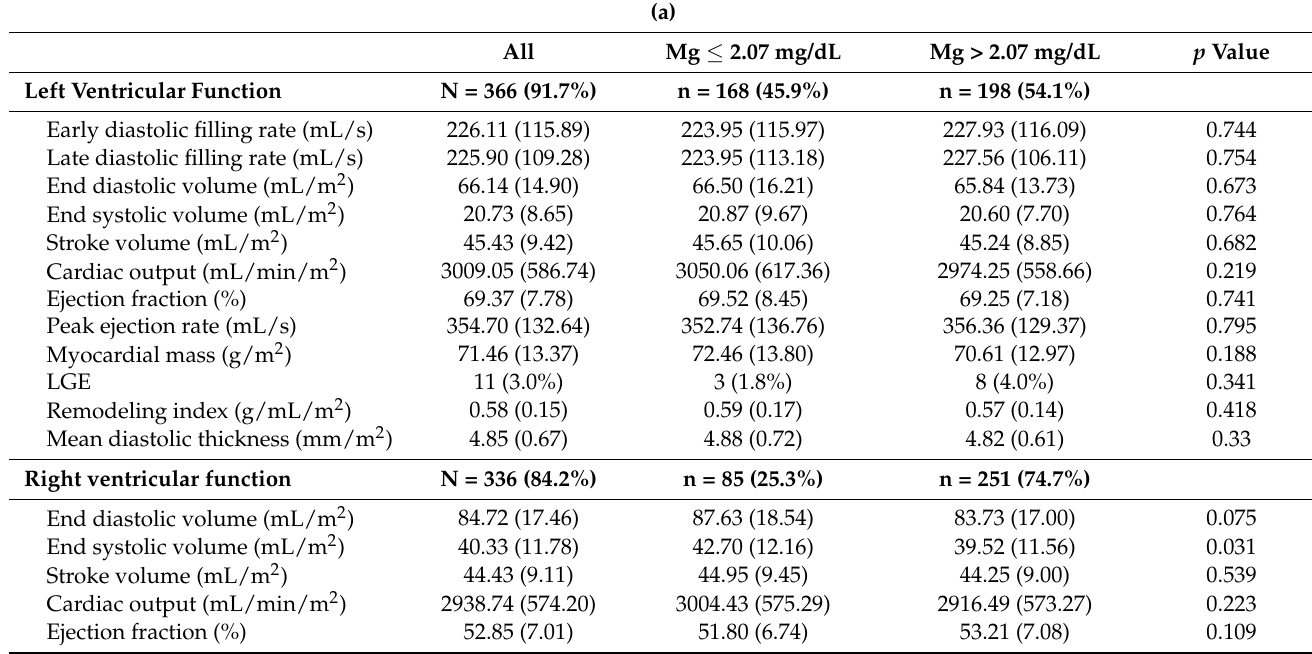
Table 2. ( a ): Imaging markers of subclinical cardiovascular disease by serum magnesium status. ( b ): Imaging markers of subclinical cardiovascular disease by dietary magnesium